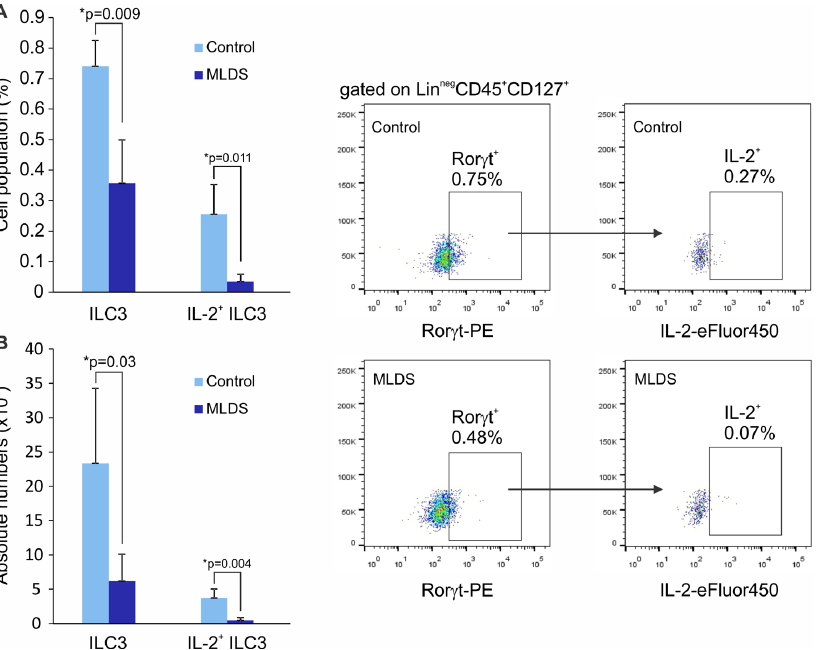
Figure 4. Diabetic C57BL/6 mice have lower frequencies of IL - 2 - producing ILC3 in the SILP. Proportion of total ILC3 and IL - 2 - producing cells among Lin neg CD45 + CD127 + RORγt + ILC3 ( A ) in the SILP of normoglycemic healthy mice (control) and hyperglycemic C57BL/6 mice (MLDS), and their absolute numbers ( B ). Representative dot plots are shown. Number of mice per group was 5. * p < 0.05 was considered as statistically significant when samples from healthy and hyperglycemic mice were compared.